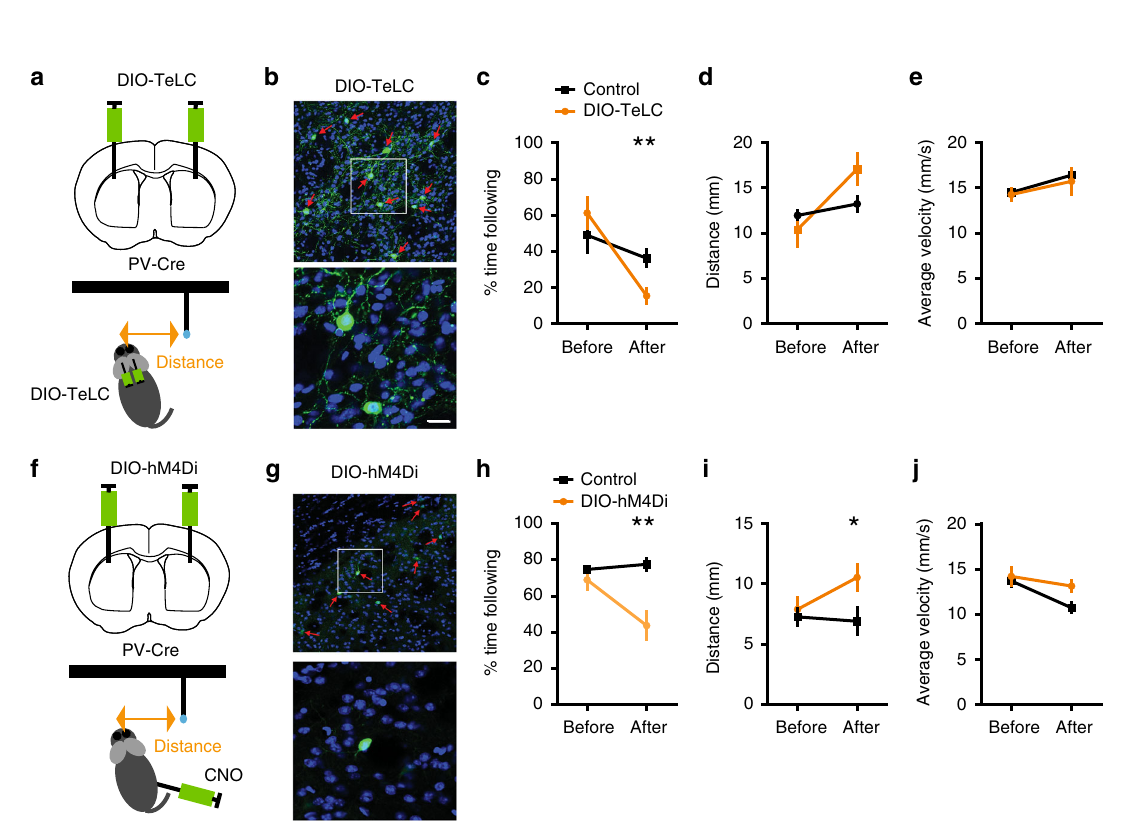
Fig. 5 Silencing FSI activity disrupts pursuit performance. a To silence neural activity in FSIs, we injected the Cre-dependent DIO-TeLC virus into the striatum of PV-Cre mice. TeLC silences neurons by cleaving the vesicular-associated membrane protein 2 and preventing transmitter release. b GFP staining showing FSIs infected with GFP-tagged TeLC (control: n = 6, DIO-TeLC: n = 7). c Duration of self-initiated pursuit behavior (% time spent following) is signi fi cantly reduced by TeLC. A repeated measures ANOVA revealed a signi fi cant interaction: F 1, 11 = 6.88, p = 0.024. Post hoc test showed a signi fi cant effect of TeLC ( p = 0.0051). ** p < 0.01. d Distance error is greater in the TeLC group compared to the Control group (GFP only). Repeated measure ANOVA: Interaction: F 1, 11 = 5.92, p < 0.05. Post hoc unpaired t -test, p = 0.09. e TeLC did not affect velocity: no signi fi cant interaction: F 1, 11 = DIO-hM4Di virus into the striatum. g GFP staining showing FSIs in the striatum infected with GFP-tagged DREAAD (control: n = 6, DIO-hM4Di: n = 6). h hM4Di reduced % time spent following the target. There was a signi fi cant interaction: F 1, 10 = 15.2, p = 0.0030. Post hoc test revealed a signi fi cant